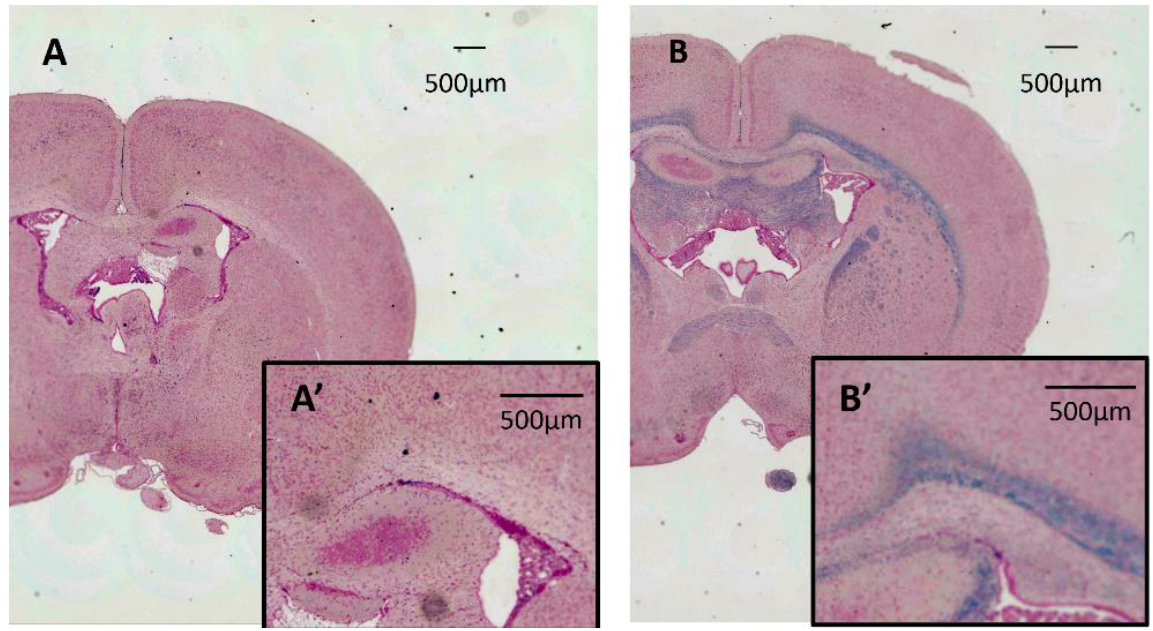
Figure 6. Results of Luxol fast blue staining for the Tama and control rat brains. The Tama rat brain ( A ) shows no myelin staining, and the control rat brain ( B ) shows dense myelin staining in the white matter. ( A ′ , B ′ ) are magnified myelin. Each of the scale bars shows 500 µm.